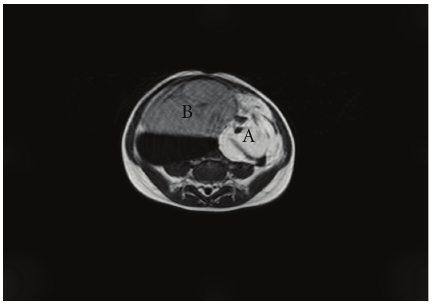
Figure 3: T1 transverse section of abdominal magnetic resonance scan showing intermediate signal in solid component (A) with low signal areas representing calcification and low signal in cystic component (B).